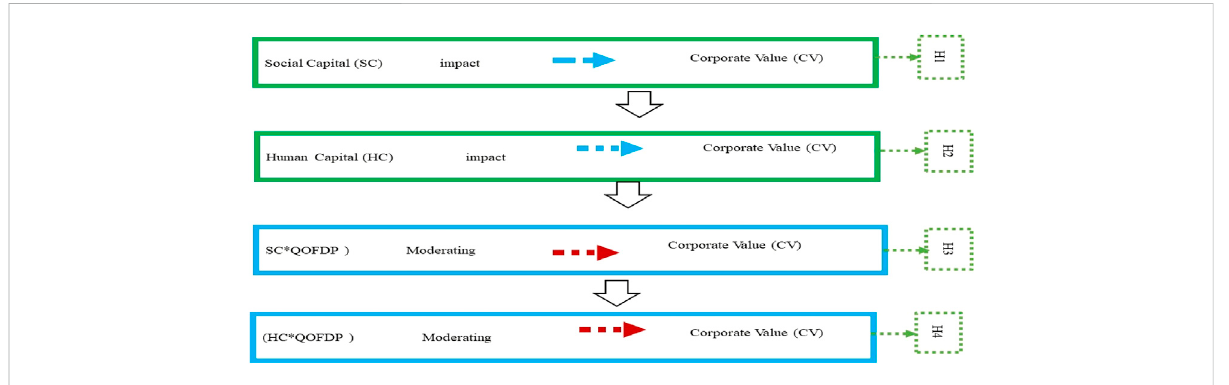
FIGURE 1 Hypothesis development.